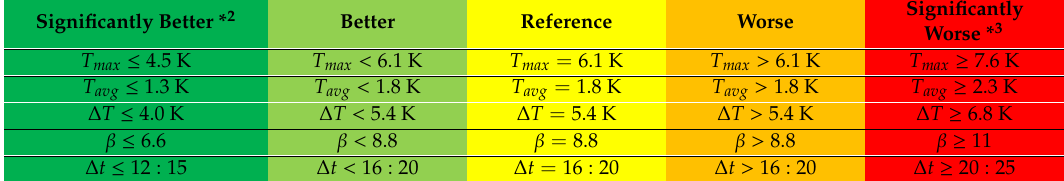
Table 2. Rating criteria and associated thresholds for the model study comparison.* 1 Significantly Better * 2 Better Reference Worse